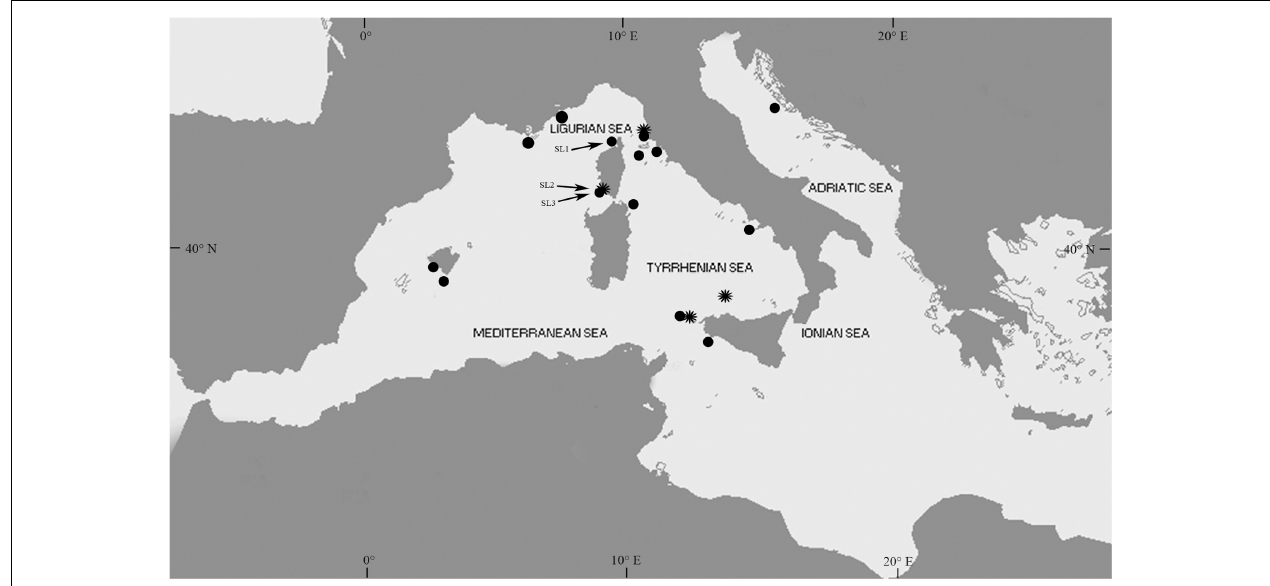
FIGURE 1 | Map of the localities with Posidonia oceanica recruitment citations since the first in situ seedling record of 1986 until 2016. SL1, SL2, and SL3 indicate the three localities in Corsica (France), Saint Florent, where recruits were observed in July 2006, and Ventilegne and Tonnara where recruits were observed in July 2016. The symbol ∗ indicates the four localities that received consistently high recruit inputs.